Question: Briefly state, in one sentence, what is plotted here.
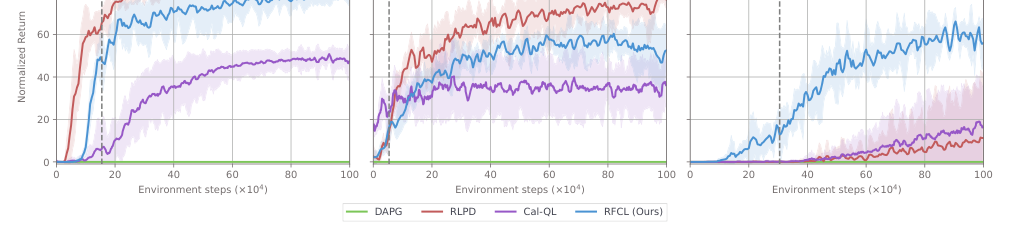
Answer: Adroit Results with random demonstrations. Results averaged over 5 seeds with shaded area repre- senting 95% CIs. Every single seed succesfully finished the reverse curriculum and the success rate (not shown) reached near 100%. The normalized return of RFCL plateaus just below the state-of-the-art method RLPD for the two easier environments, but significantly outperforms RLPD and Cal-QL on the harder Adroit Relocate environment.